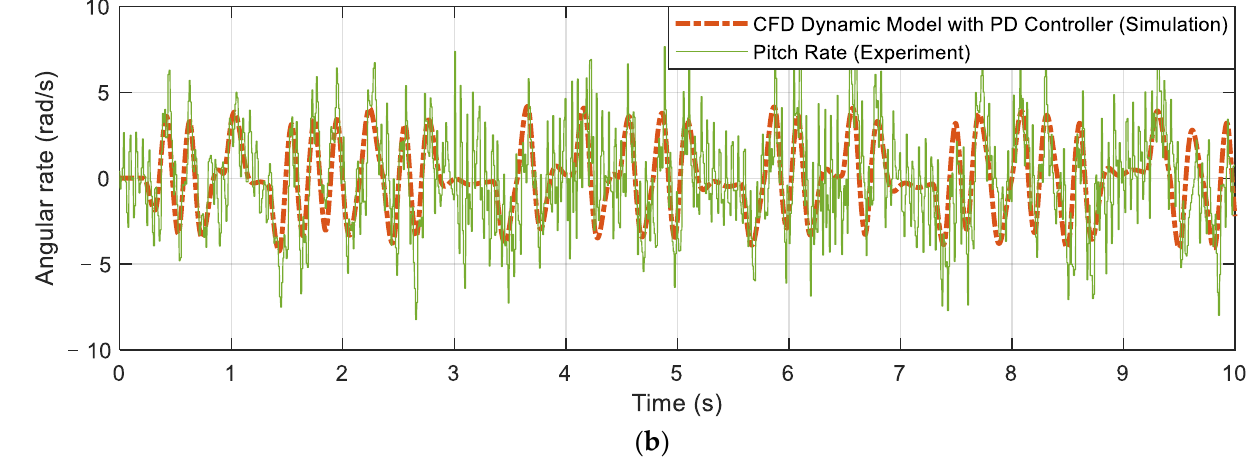
Figure 6. Experimental flight data and simulation results for system identification with irregular square reference inputs: ( a ) pitch angle responses, and ( b ) pitch rate responses.